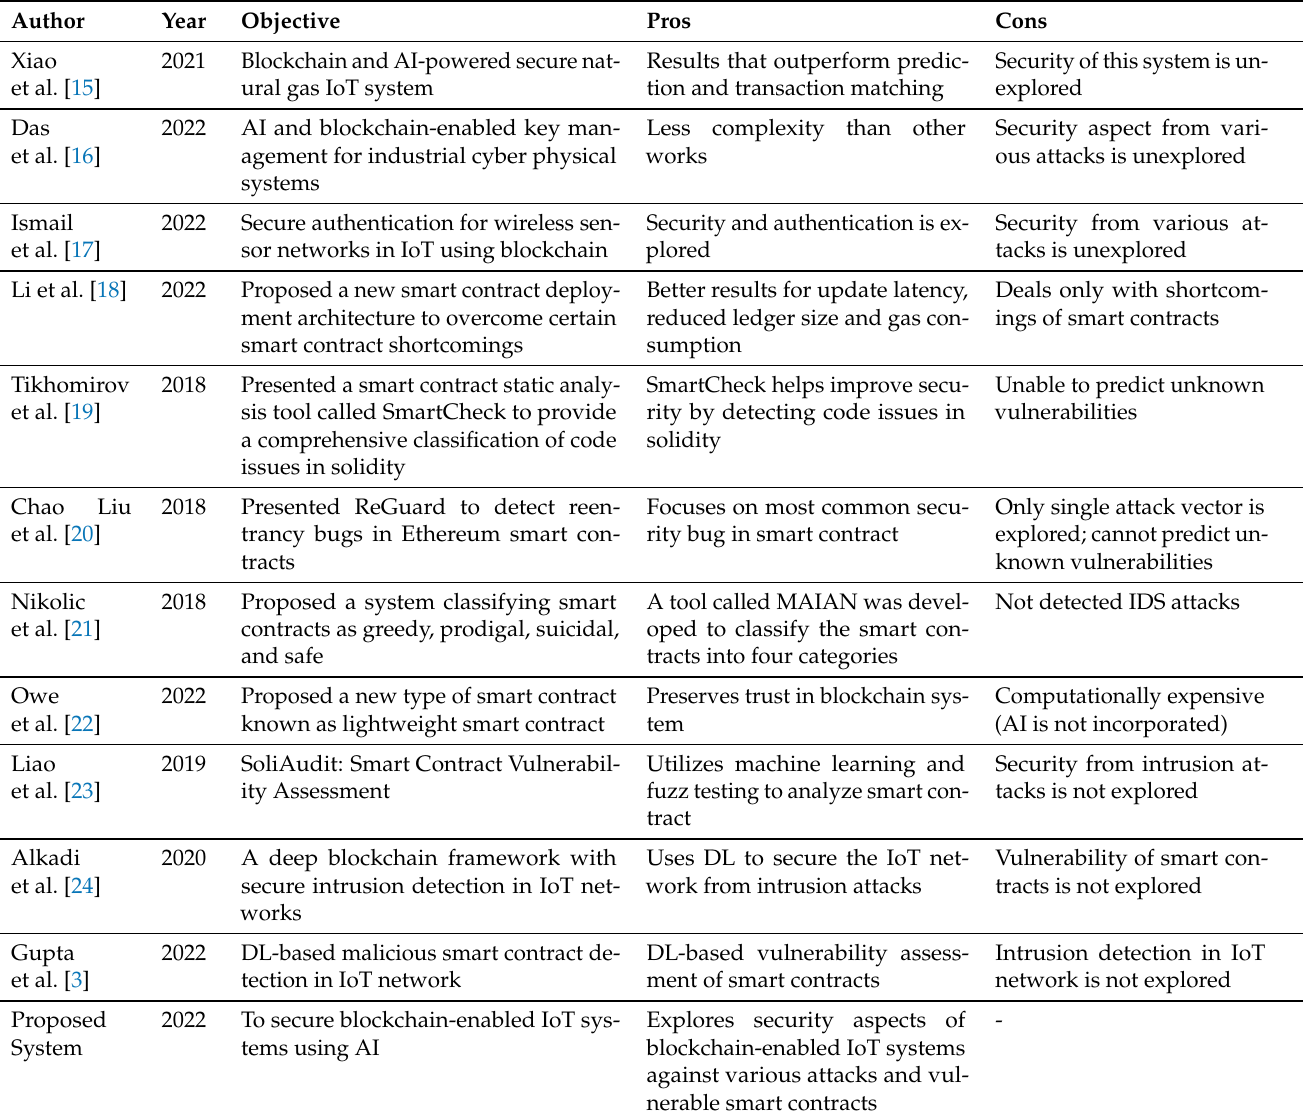
Table 1. Comparing the existing works with the proposed work by considering different